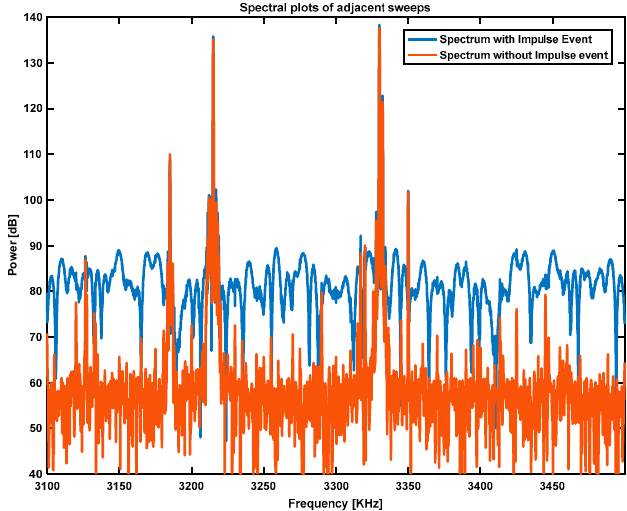
Figure 5. Illustration of the spectral power of two adjacent time sweeps. It can be readily observed that the sweep with the impulse event present (blue trace) had a considerably higher noise floor than the non-impulse-contaminated sweep (red trace).